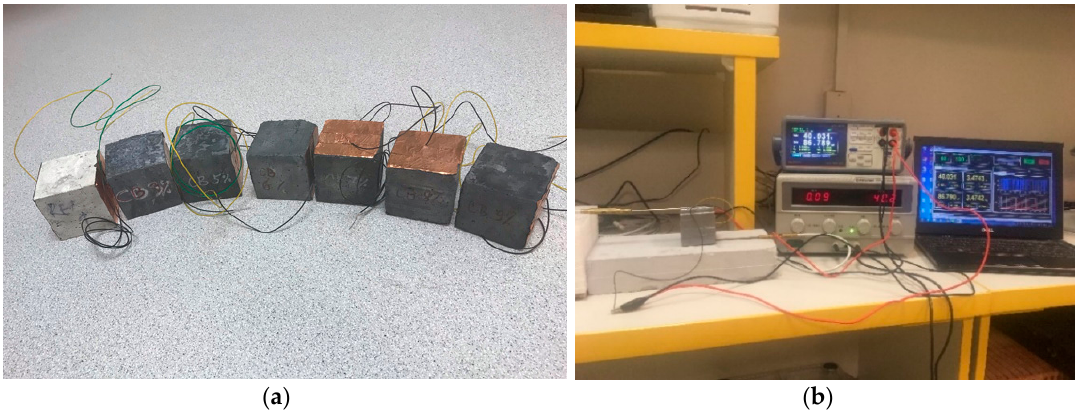
Figure 2. ( a ) Samples for self-heating experiments. ( b ) Apparatus for self-heating experiments.